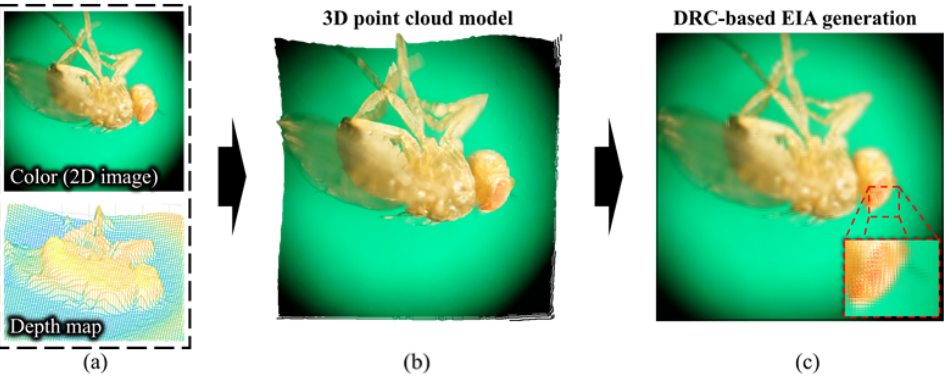
Figure 6. Process of EIA generation for 3D visualization; ( a ) depth and color information, ( b ) gener- ated 3D point cloud, and ( c ) corresponding EIA based on